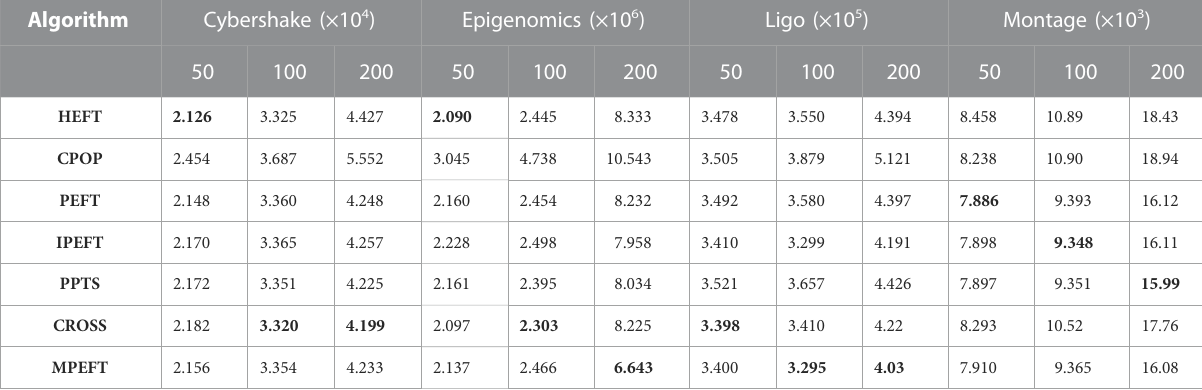
TABLE 7 Experimental results in terms of makespan standard deviation on real-world work fl ows. Algorithm